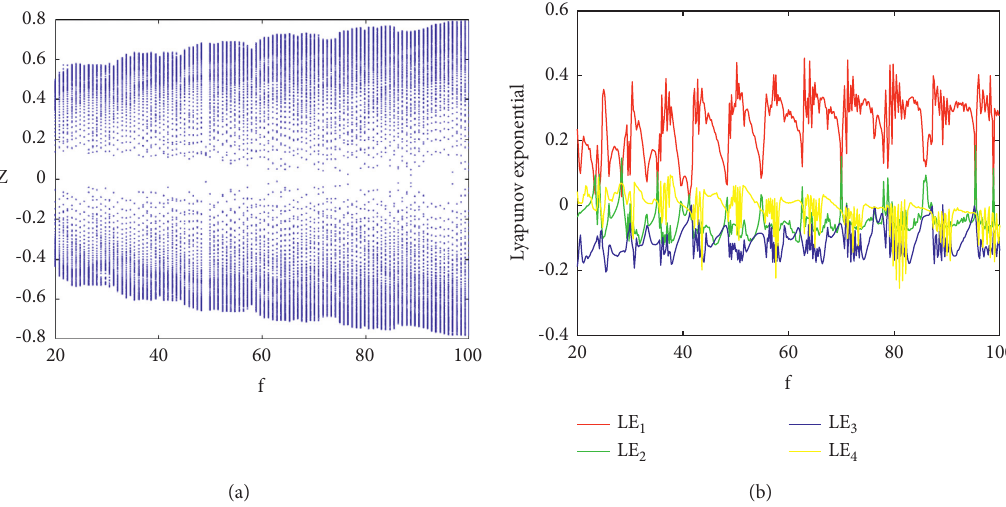
Figure 7: Bifurcation diagram and Lyapunov exponential spectrum of the system when parameter f changes. (a) Bifurcation diagram with f . (b) Lyapunov exponential with f .